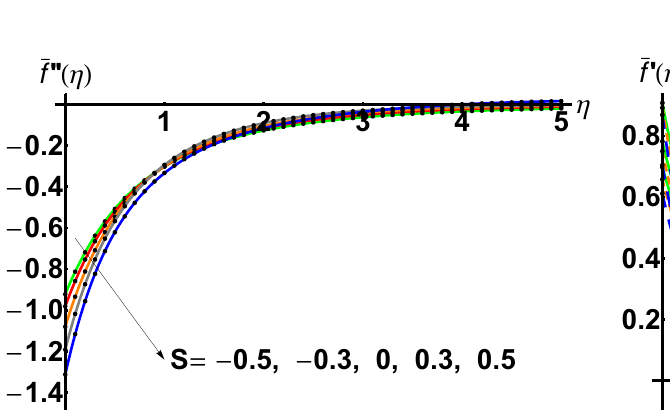
Figure 6: Variation of the stream function ¯ f ( η ) with increasing of the slip parameter λ for different values of the suction/blowing parameter S : •••••••• numerical solution ; OHAM solution (with lines and dashing lines respectively)